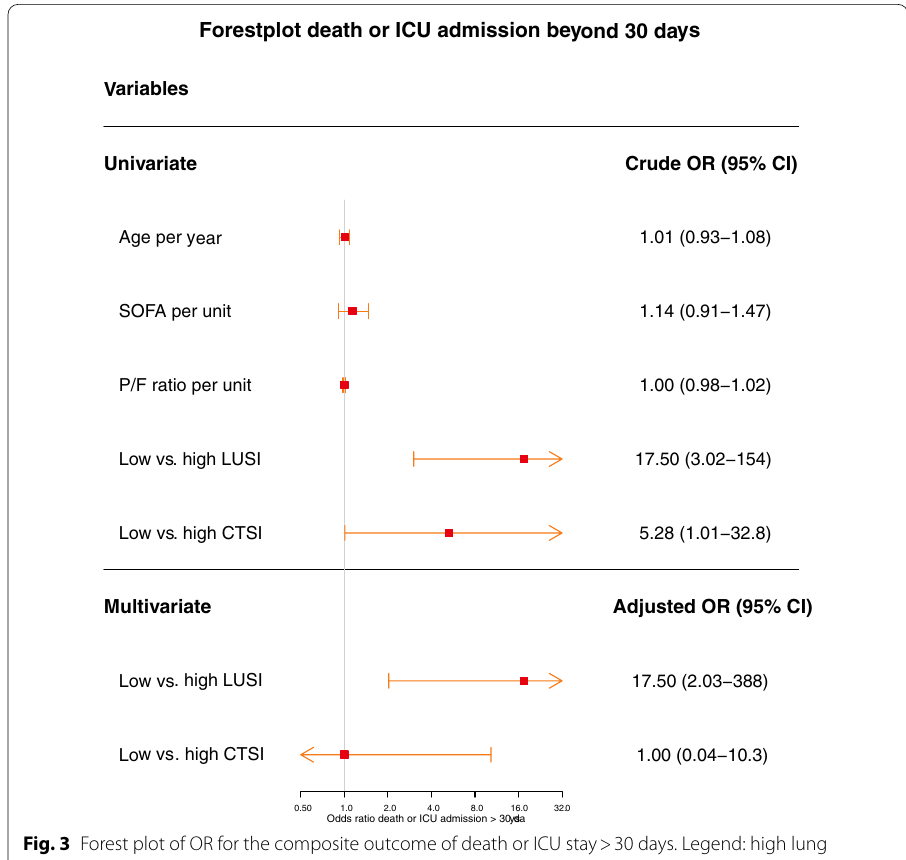
Fig. 3 Forest plot of OR for the composite outcome of death or ICU stay > 30 days. Legend: high lung ultrasound score involvement index (LUSI) was 50% whereas high computed tomography severity ≥ involvement index (CTSI) was 65%. Only statistically significant variables were included in the multivariate ≥ model. OR odds ratio; ICU intensive care